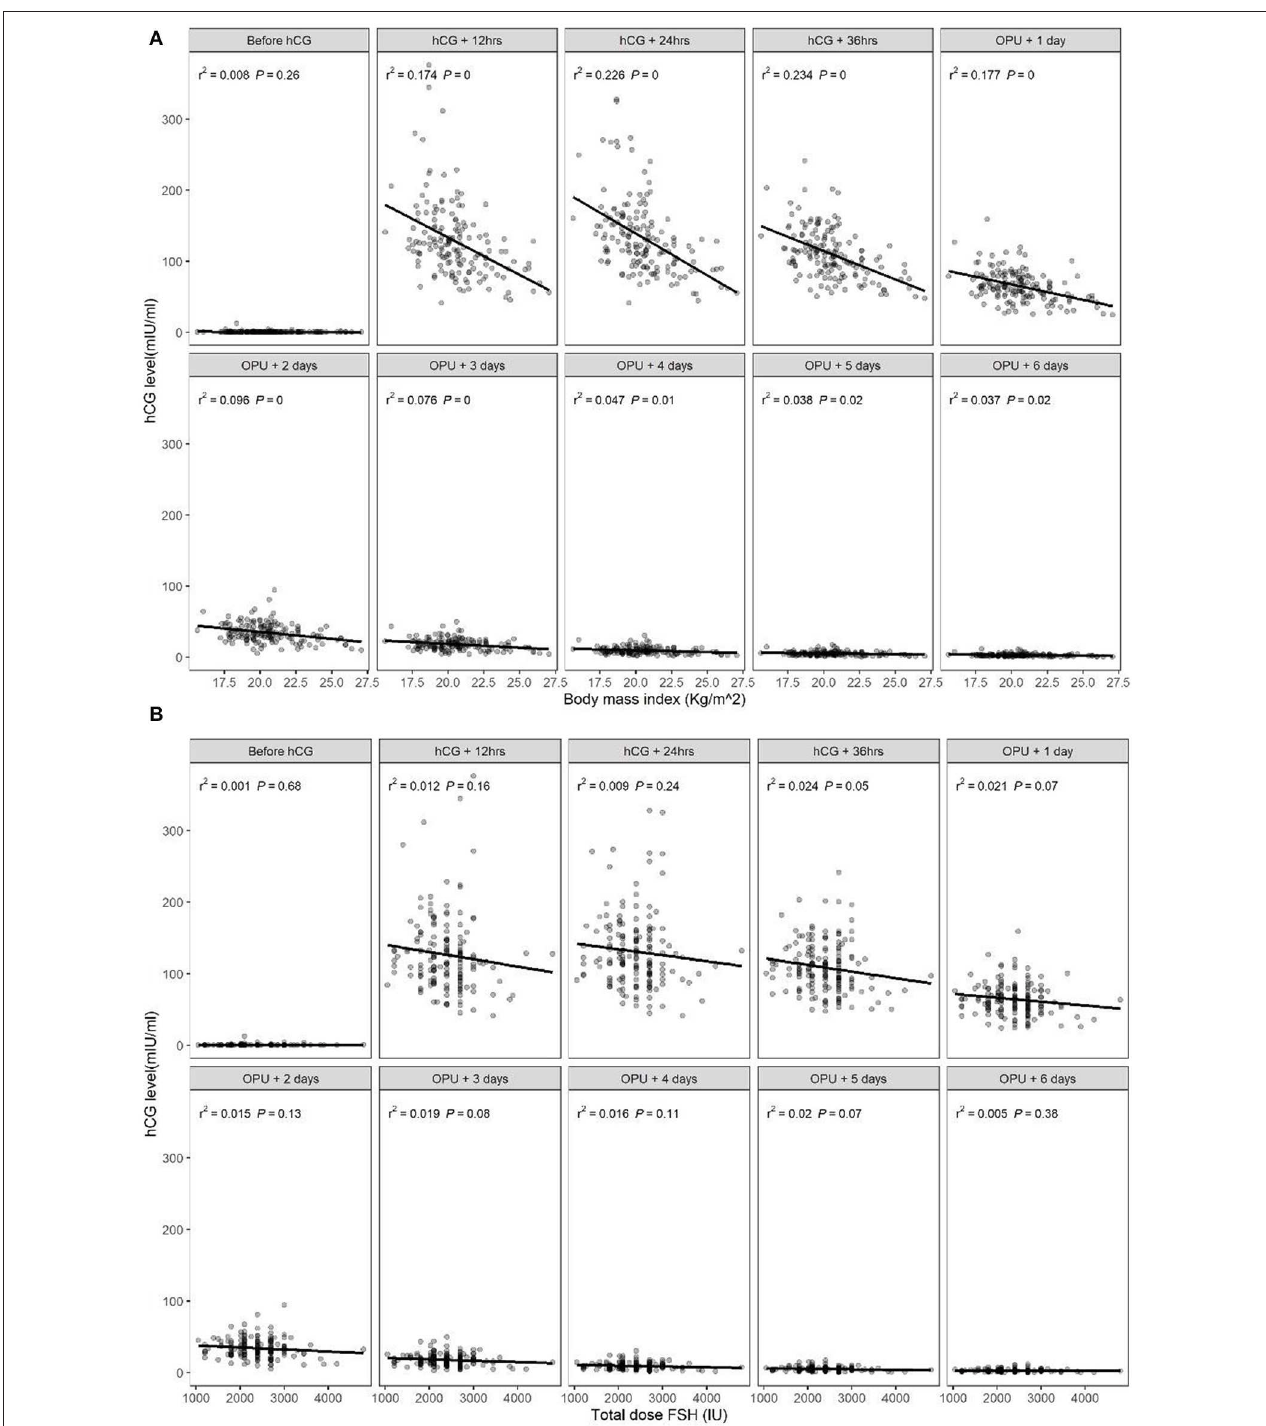
FIGURE 1 | Relationship between serum human chorionic gonadotropin (hCG) levels in the early luteal phase and (A) body mass index (BMI) or (B) total dose of follicle-stimulating hormone (FSH).